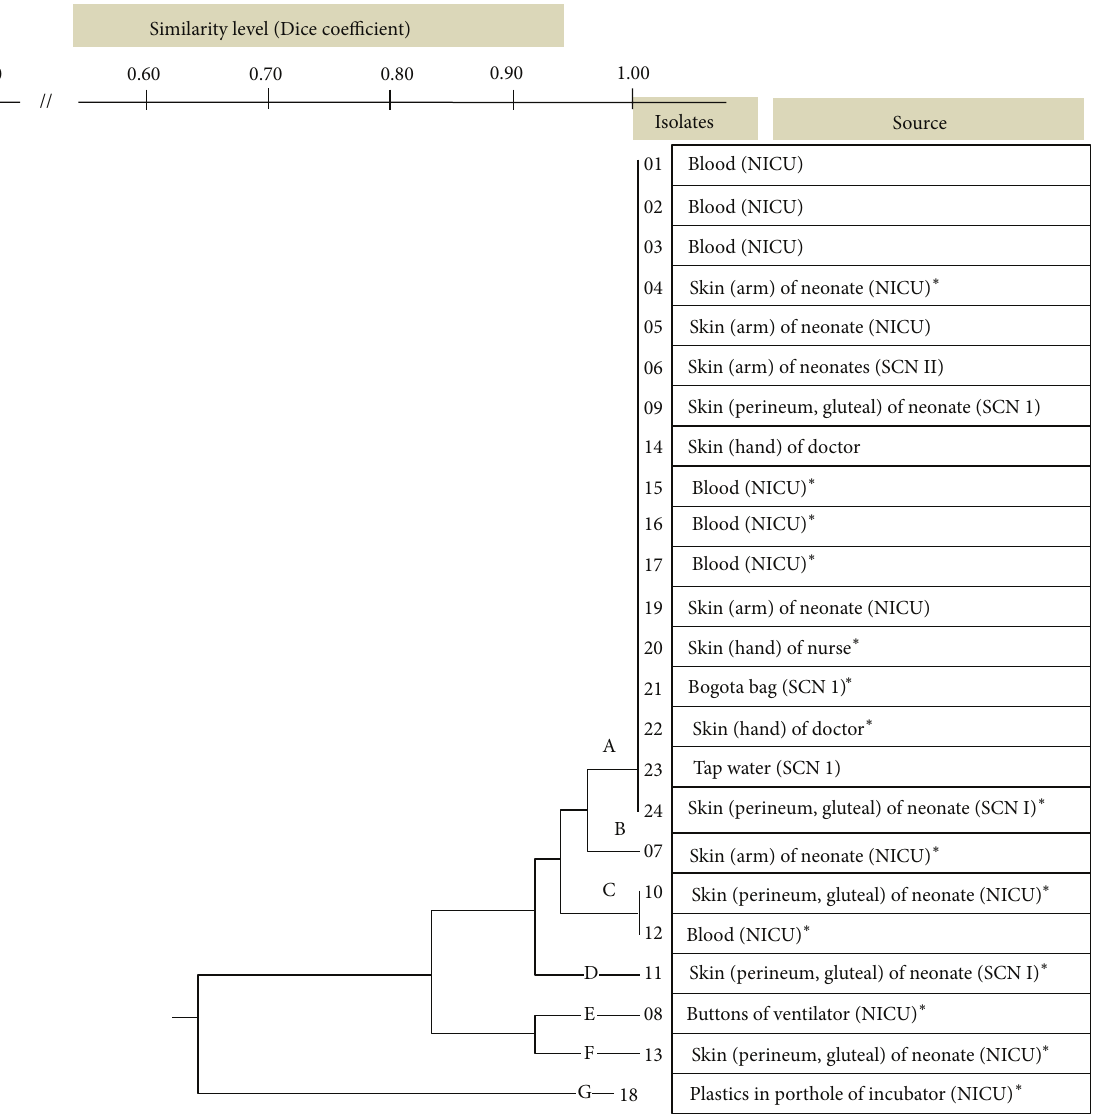
Figure 3: Phenogram of A. baumannii isolates. Seven pulsotypes (“A”–“G”) were identified. Twenty-three isolates (96%) showed a high degree of similarity with Dice coefficient 0.8–1.0, that is, pulsotype “A”–“F”. ∗ Identical